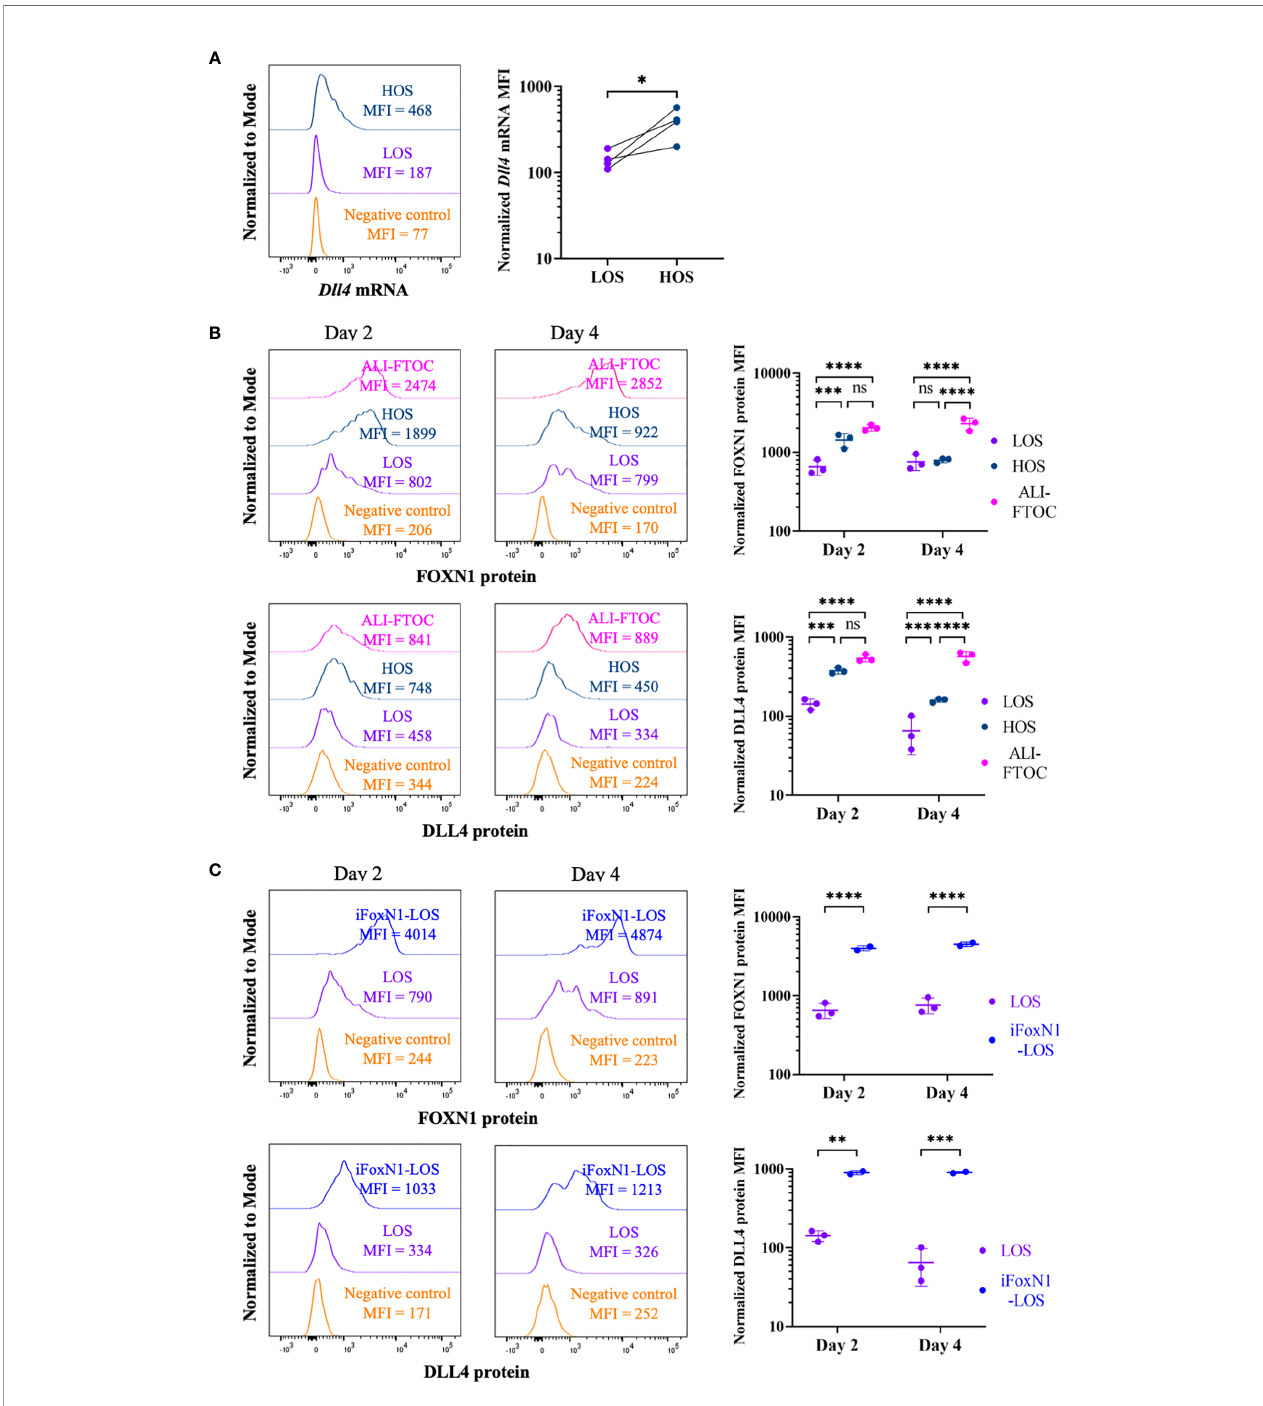
FIGURE 1 | Regulation of FoxN1 and Dll4 expression by oxygen availability. (A) The left panel shows representative histogram overlays of Dll4 transcript levels using PrimeFlow RNA assay and the right panel shows scatter dot plots and statistical analysis (ratio paired Student ’ s t-test) of the mean fl uorescence intensity (MFI) of Dll4 transcript, as indicated. (B) Flow cytometric analysis of intracellular FOXN1 and cell surface DLL4 expression in TECs from LOS-, HOS-, and ALI-FTOC, as indicated. Representative histogram overlays and statistical analysis (two-way ANOVA with post-hoc Tukey ’ s test) are shown for FOXN1 (top panels) and DLL4 (bottom panels) protein expression in TECs from day 2 and day 4 cultures. (C) Flow cytometric analysis of intracellular FOXN1 and cell surface DLL4 expression in TECs from LOS and iFoxN1-LOS cultures, as indicated. Samples were pre-gated on CD45 - EpCam + cells except for negative control, which were CD45 + cells. Numbers of biologically independent trials are indicated. ns, not signi fi cant; p > 0.05; *p < 0.05; **p < 0.01; ***p < 0.001; ****p <